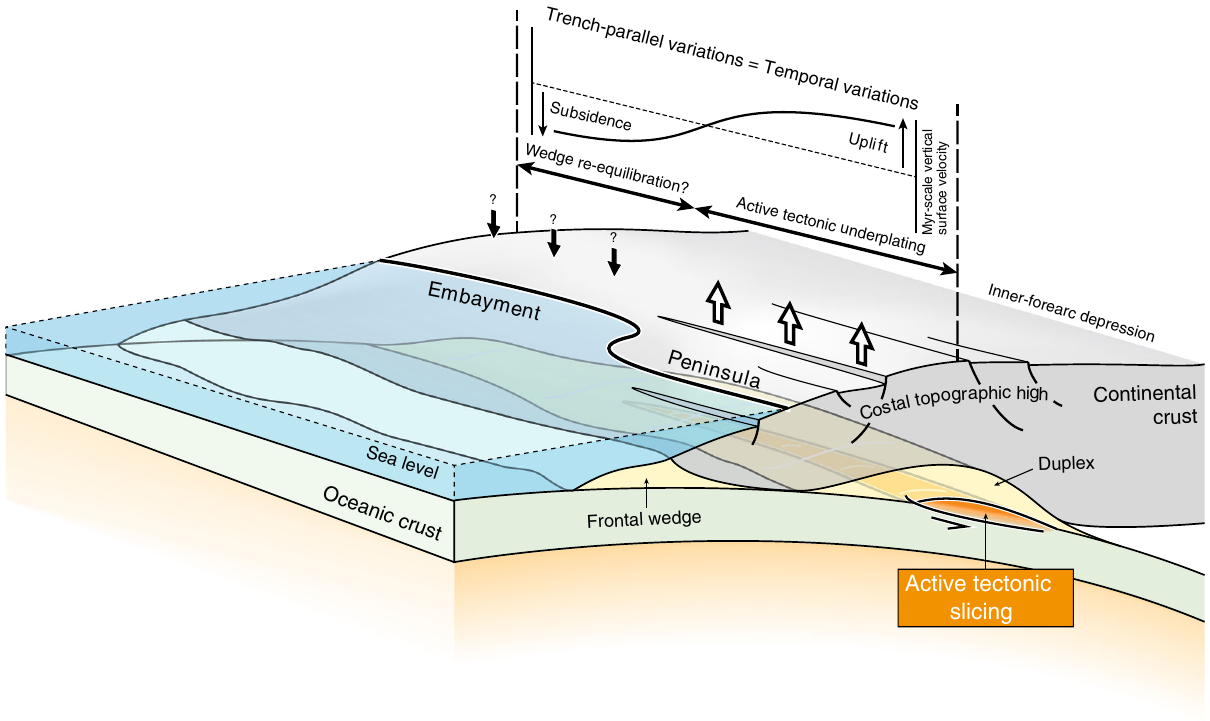
Fig. 6 Tectonic underplating, vertical surface displacements and coastal morphology. 3D schematic view of trench-parallel variations in deep accretionary dynamics, which may be considered as a proxy for temporal variations predicted in our numerical experiments (Figs. 2 and 3). A laterally constrained transient nappe stripping event (orange) along the plate-interface controls the uplift of a local forearc high, possibly resulting in the emersion of a peninsula while regions with no active underplating are characterized by subsidence and embayment due to wedge re-equilibration. Note that a single underplating event lasting a few Myr is responsible for local coastal morphology variations, while the succession of these events along the entire margin leads for duplex growth (yellow) and coastal topography rise over tens of Myr. Thick white and black arrows denote, respectively, Myr-scale uplift and subsidence along the forearc